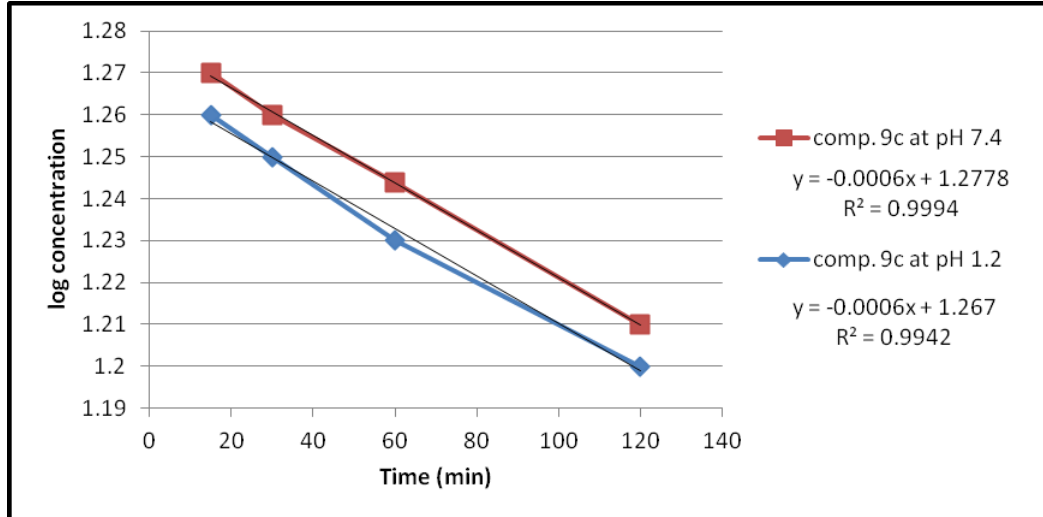
Figure 4. The hydrolysis rate of compound 9c at different pH values.